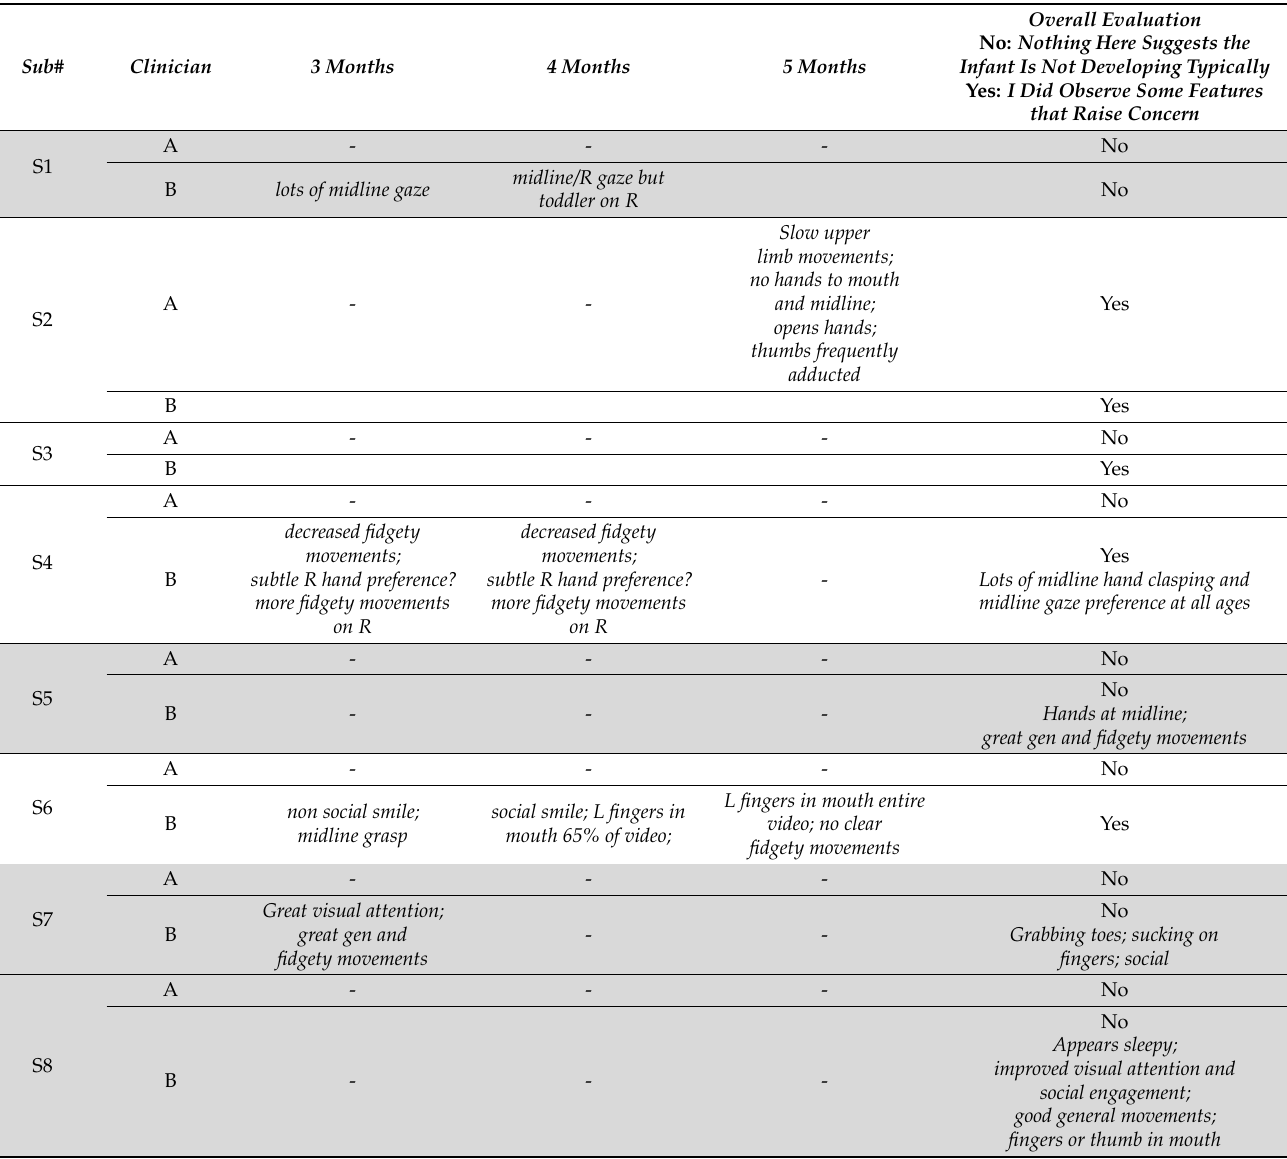
Table 1. Report of the evaluation of the RGB videos performed by two expert physicians (A and B); subjects not suggesting atypical development are